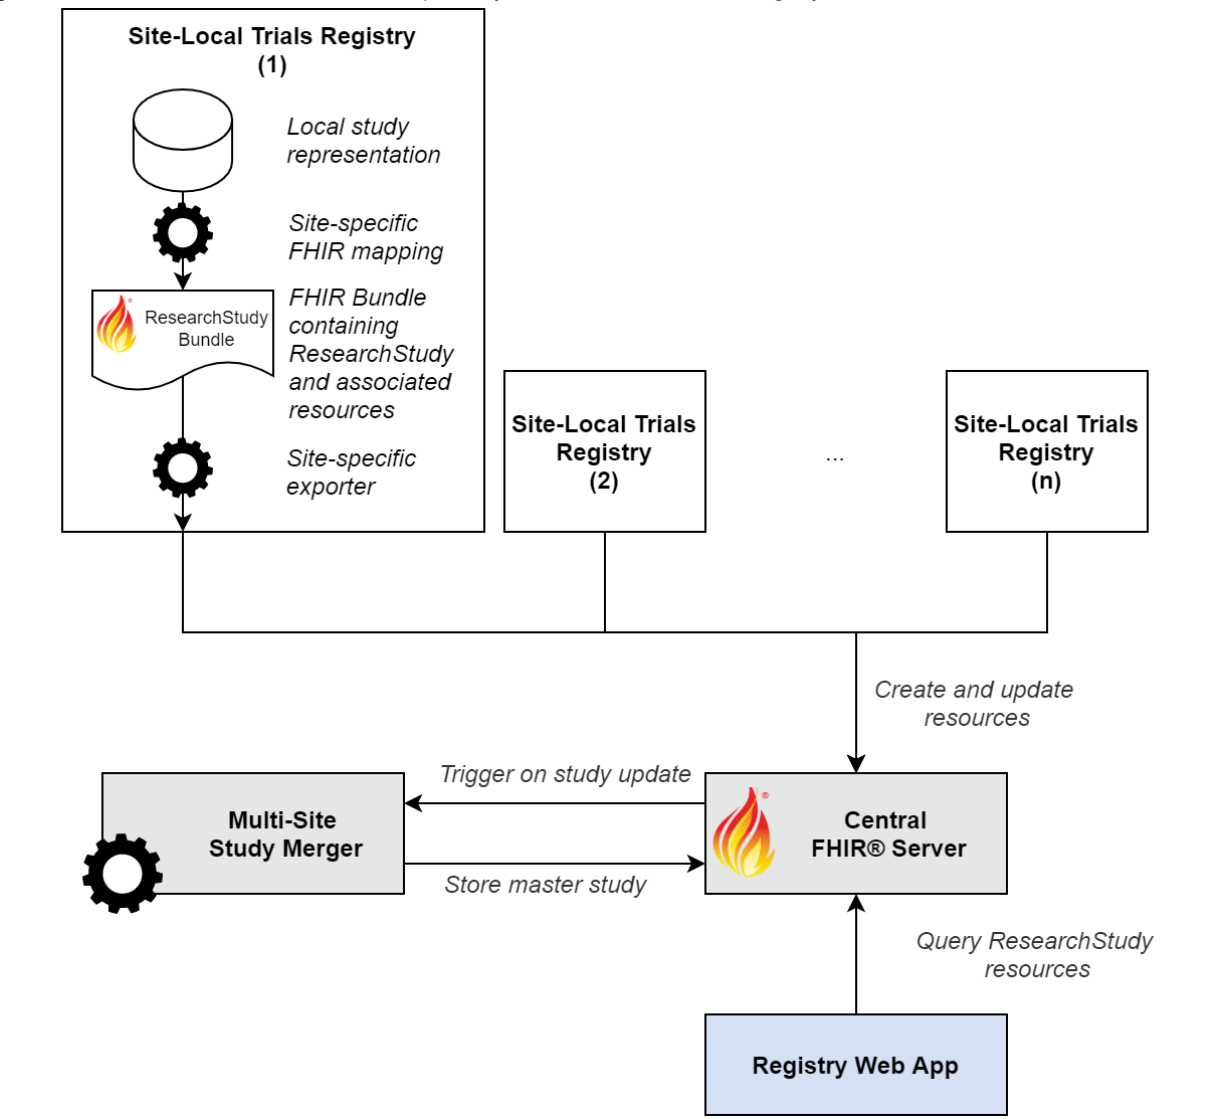
Figure 3. Architecture of the Fast Healthcare Interoperability Resource (FHIR)-based trial